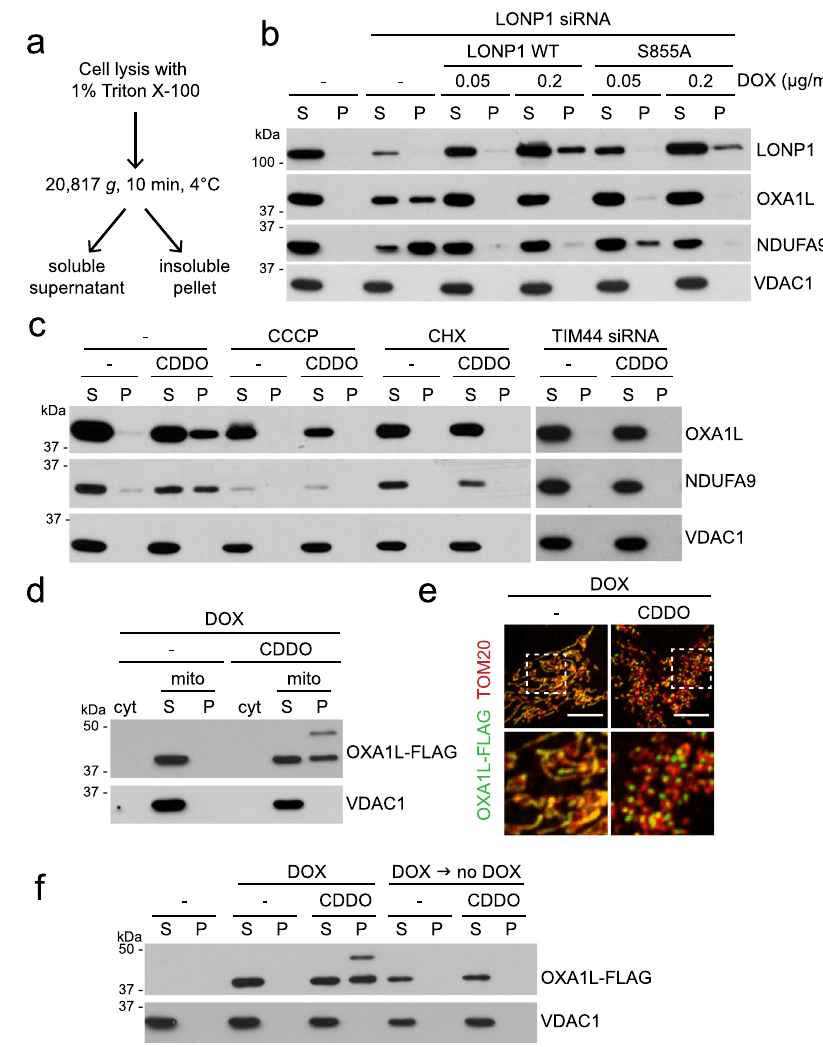
Fig. 1 LONP1 required for OXA1L and NDUFA9 biogenesis. a Schematic of Triton X-100 extraction to determine protein solubility. b Protein aggregation upon LONP1 knockdown and its rescue by protease-de fi cient LONP1. Triton X-100 extraction and Western blotting were used to examine protein solubility in LONP1 knockdown 143B cells re-expressing doxycycline (DOX)-inducible RNAi-resistant LONP1 WT and protease-de fi cient LONP1 S855A . c Protein insolubility with CDDO treatment, and its rescue by drug treatment or TIM44 knockdown. Triton X-100 extraction and Western blotting were used to examine protein solubility in 143B cells treated with vehicle (-) or CDDO. Additional drug treatment (CCCP or CHX) or TIM44 knockdown was performed as indicated. d Solubility of OXA1L-FLAG. Mitochondria were isolated from 143B cells expressing doxycycline (DOX)-inducible OXA1L-FLAG and analyzed by Triton X-100 extraction and Western blotting. Expression was induced by DOX for 16 h in the absence or presence of 2 μ M CDDO. cyt, cytosol; mito, mitochondria. e Visualization of OXA1L-FLAG aggregation. OXA1L-FLAG was induced by DOX in the absence or presence of 2 μ M CDDO, and visualized by anti-FLAG immunostaining. Tom20 was used as a mitochondrial marker. Scale bar, 10 μ m. f Temporal features of OXA1L aggregation. Triton X-100 extraction and Western blotting were used to examine OXA1L-FLAG solubility. Cells were treated with DOX and 2 μ M CDDO for 24 h simultaneously or treated with DOX for 24 h, and after DOX removal, treated with 2 μ M CDDO for an additional 24